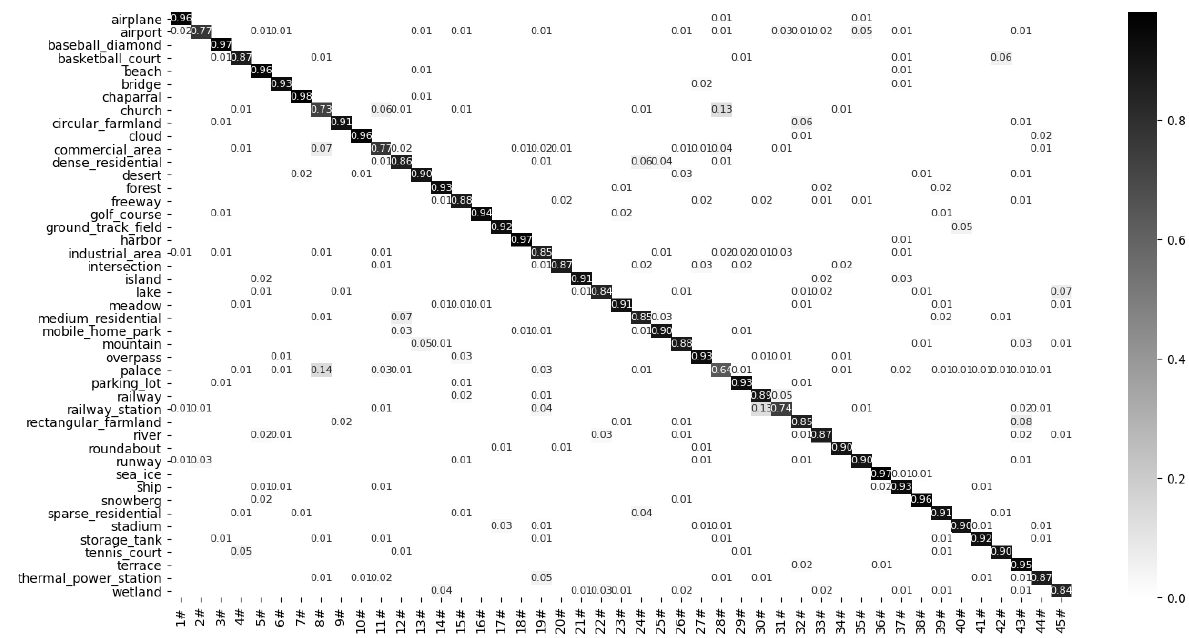
Figure 13. Confusion matrix of the proposed method on the AID30 dataset (50/50).